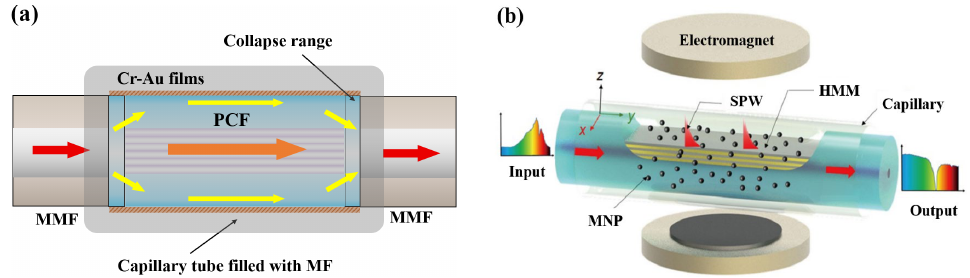
Figure 8. Magnetic field fiber sensors based on SPR with ( a ) MMF-PCF-MMF structure [62] and ( b ) HMMs (reprinted with permission from Ref. [33], 2022, Springer Nature).